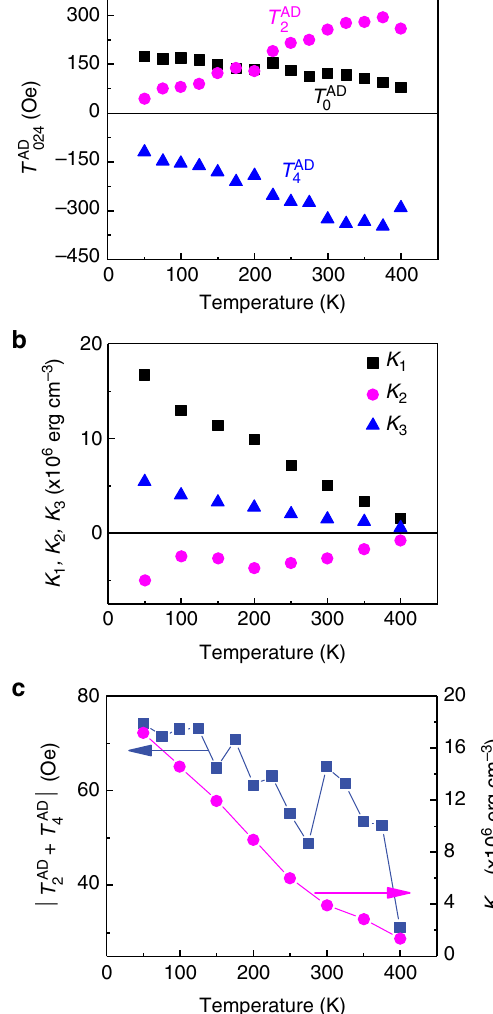
Fig. 4 Temperature effects on the current-induced torque and magnetic anisotropy. a Temperature dependence of the zeroth- ( T 0 AD ), second- ( T 2 AD ), and fourth-order ( T 4 AD ) terms in T AD . b Temperature-dependent K